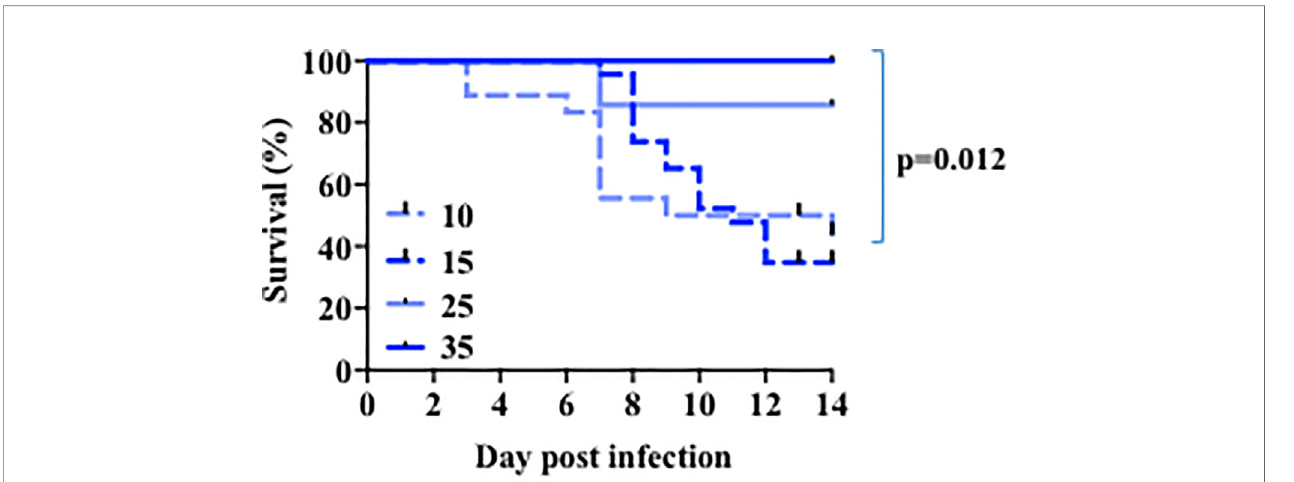
FIGURE 1 | Age-related susceptibility to a sublethal dose of PR8 in fl uenza virus. The 10 days-old mice group (n=18) received 140-200 EIU (~30 EIU per gram of weight) of live PR8 in fl uenza virus, the 15 days-old mice group (n=23) received 200 EIU (~30 EIU per gram of weight), the 25 days-old mice group (n=7) received 300 – 900 EIU (~30 EIU per gram of weight), the 35 days-old mice group (n=6) received 3000 EIU (~ 200 EIU per gram of weight). Survival was followed. Solid lines, older mice. Dotted lines, infant mice. p value, comparison of curves for day 15 and 35 by Mantel-Cox test. Analysis is of total data obtained from 12 independent cohorts of